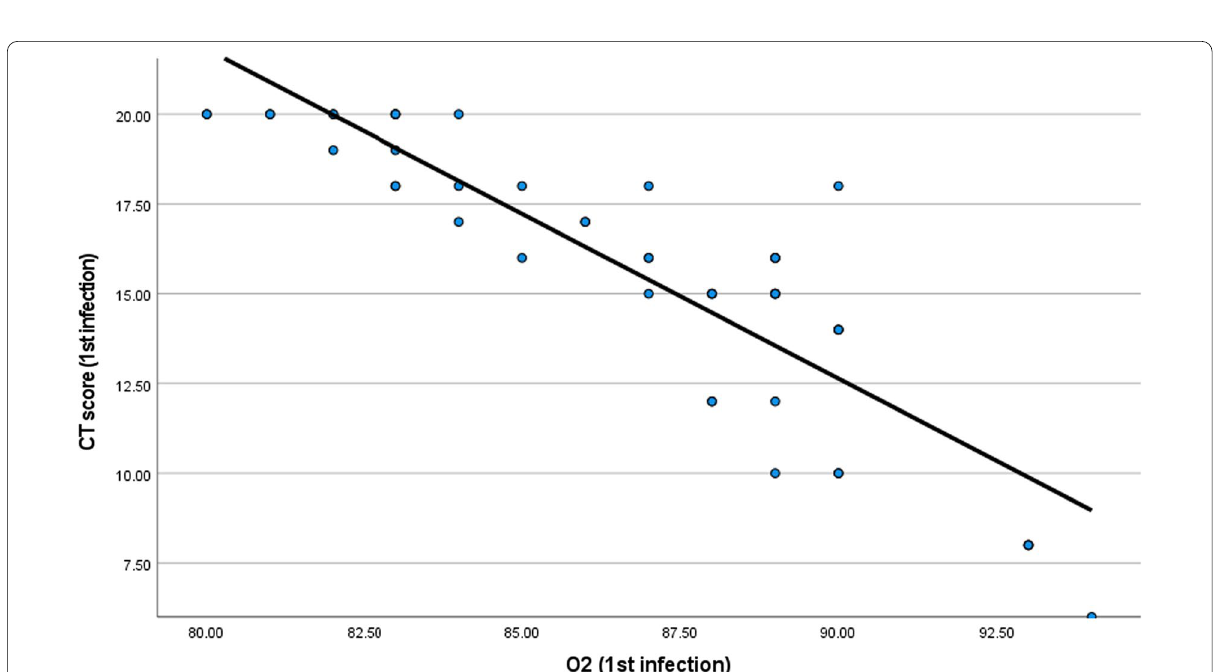
Fig. 8 Relation between CT severity score and O 2 saturation during first